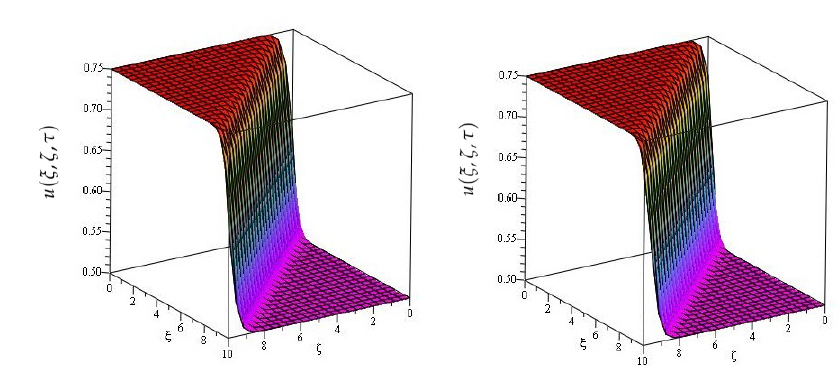
Figure 2. The numerical solution graph of u ( ξ , ζ , τ ) of Example 1 at α = 0.8 and